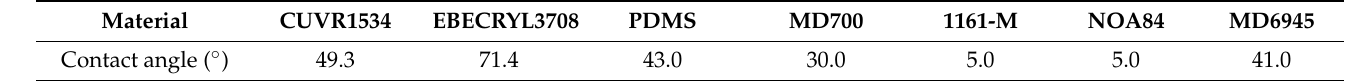
Table 1. Table of static contact angle of polymeric resins on the surface of